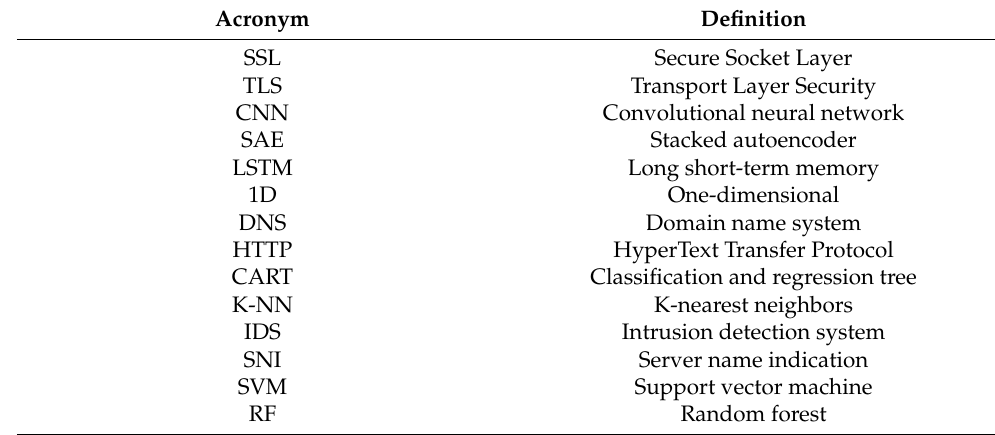
Table 1. Summary of acronyms in this